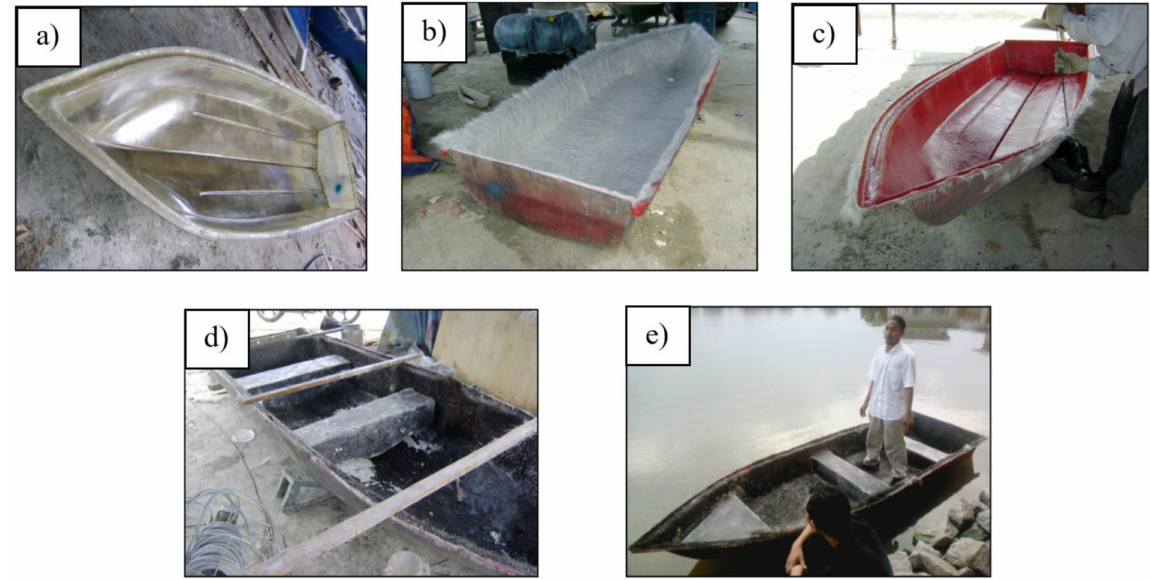
Figure 14. Steps of boat fabrication from hybrid material of sugar palm fiber and glass fiber ( a ) gel coat and catalyst were applied onto the inside surface of the mould ( b ) lay-up process for glass fiber with consistent orientation ( c ) mixture of unsaturated polyester resin and catalyst spread on top of the fiber glass and rolled using iron roller ( d ) lay-up process for sugar palm fiber, followed with the same process at ( c , e ) painted with powder reinforcement unsaturated polyester to protect all material such as sugar palm fiber and glass fiber from water. Reproduced from ref.